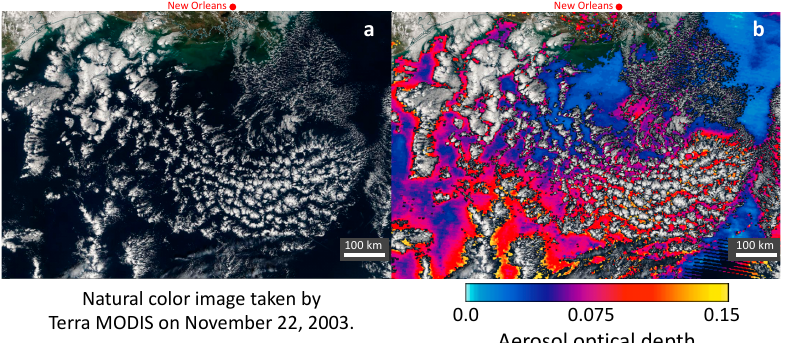
Figure 1. A sample scene over the Gulf of Mexico just south of New Orleans, illustrating near-cloud aerosol enhancements. ( a ) Natural color MODIS image; ( b ) 550 nm aerosol optical depth (AOD) provided for cloud-free areas at 3 km resolution by the MODIS operational Dark Target aerosol product [39,40]. The images are from https://worldview.earthdata.nasa.gov/. The structure of near-cloud areas in parts of this image were analyzed in [38]. High-resolution examples of near-cloud aerosol enhancements observed in 2013 slightly north and west of this scene were shown in